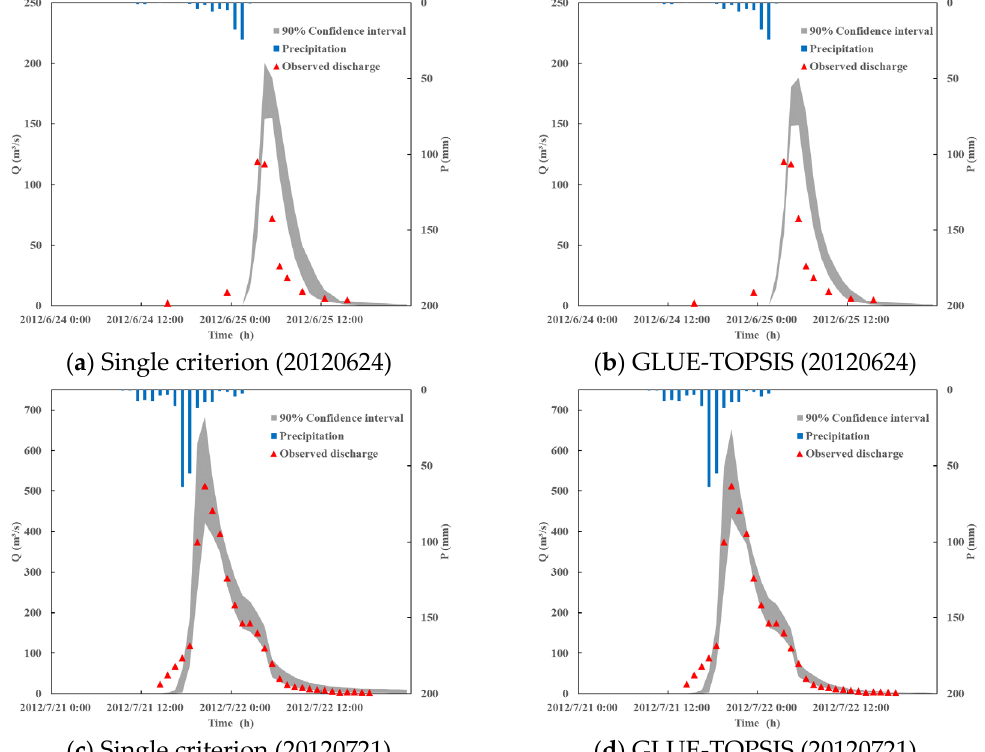
Figure 5. Multiple-criteria decision analysis (MCDA) analysis results for rainstorm event 20120624, 20120721 in validation period. Table 3. Uncertainty interval evaluation